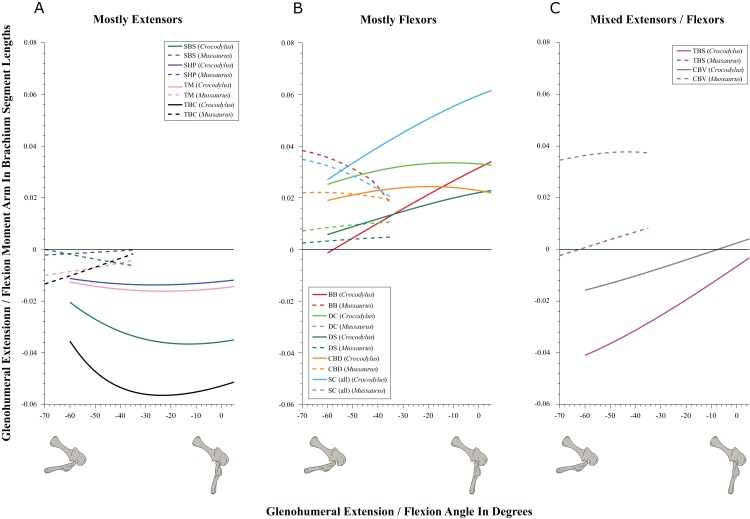
Extension/flexion moment arms around the glenohumeral joint, normalized to humerus segment length, plotted against extension/flexion joint angles for Crocodylus and Mussaurus in the resting pose.(A) Mostly extensors; (B) mostly flexors; (C) mixed extensors/flexors. Negative moment arms and glenohumeral angles correspond to extension, while positive values correspond to flexion. For muscle abbreviations see Table 1.